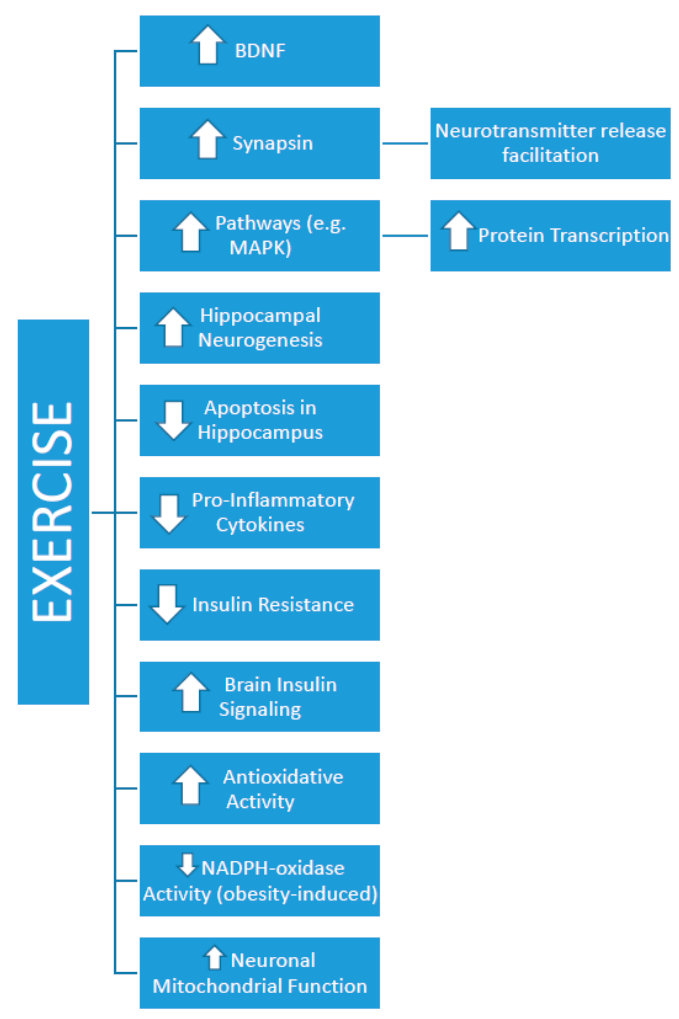
Figure 1. Schematic illustrating the mechanistic role through which exercise may counteract a high-fat diet-induced impairment of memory function.